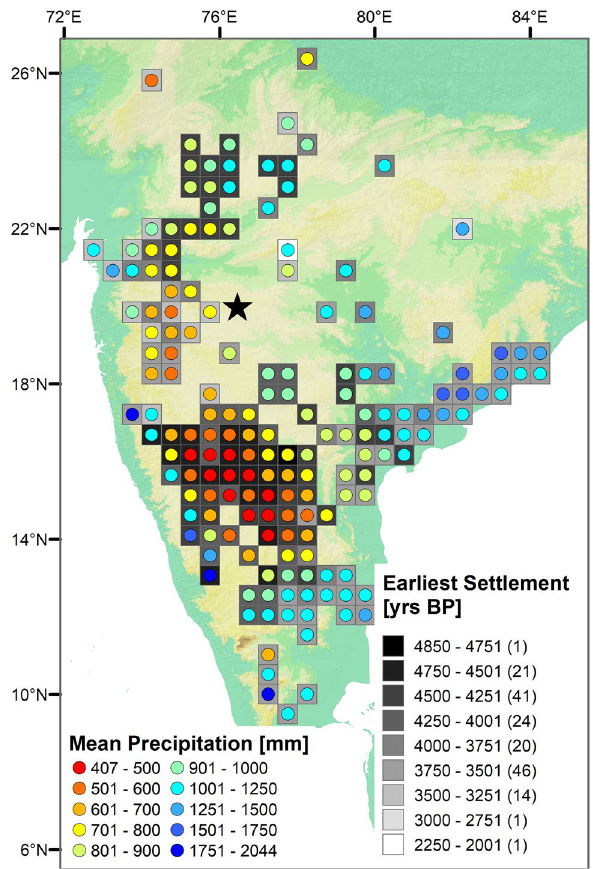
Figure 5. Distribution and first appearance of Neolithic/Chalcolithic settlements in peninsular India, along with modern patterns of MAP (Based on SI: Tab. 2). Map made with ArcGIS 10.7.1 (ESRI, 2019) 45